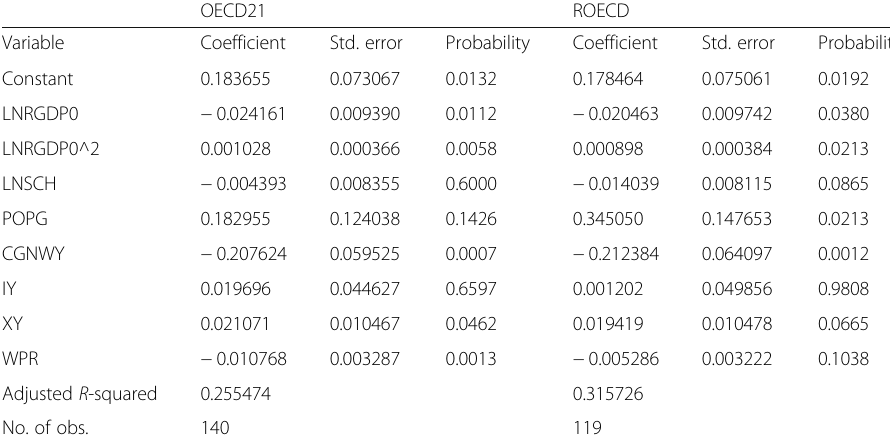
Table 10 Barro regression including